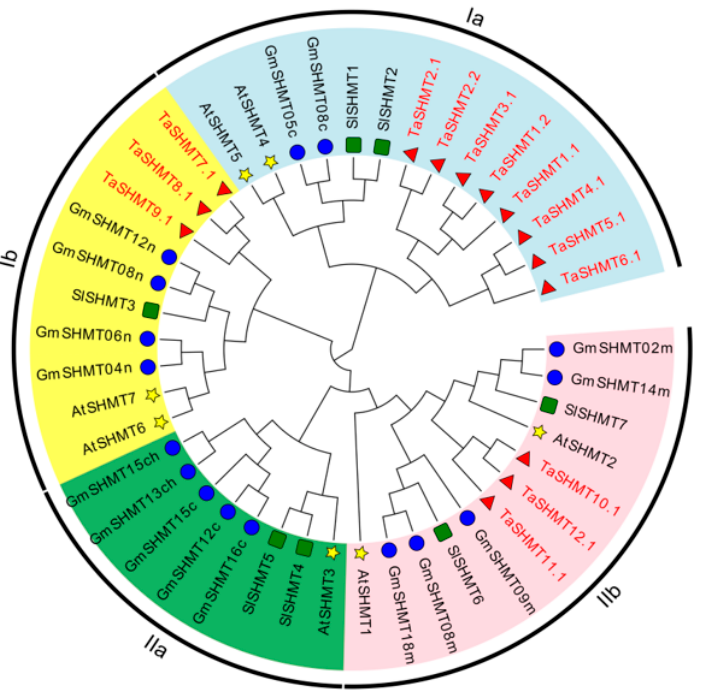
Figure 1. The Maximum Likelihood (ML) phylogenetic tree of SHMT proteins. The tree was constructed with amino acid sequences of identified SHMT proteins in A. thaliana (At), G. max (Gm), S. lycopersicum (Sl), and T. aestivum (Ta) with bootstrap values of 1000 replicates. Different groups of SHMT proteins are distinguished by different colors.